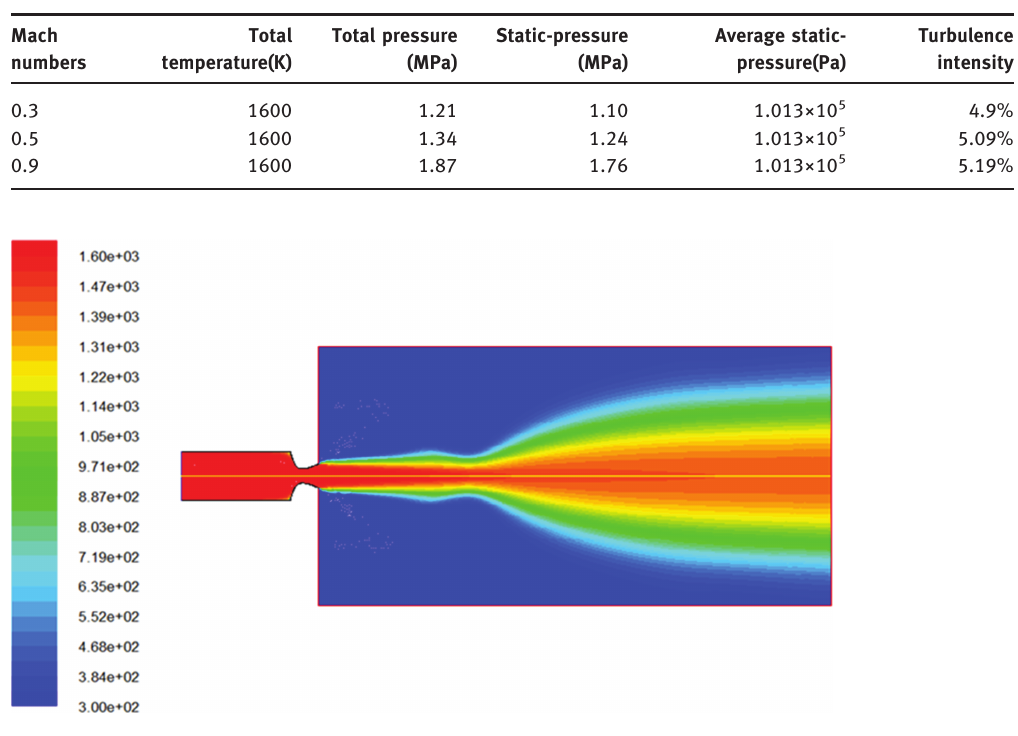
Figure 4: The contours of gas temperature at Mach 0.3.